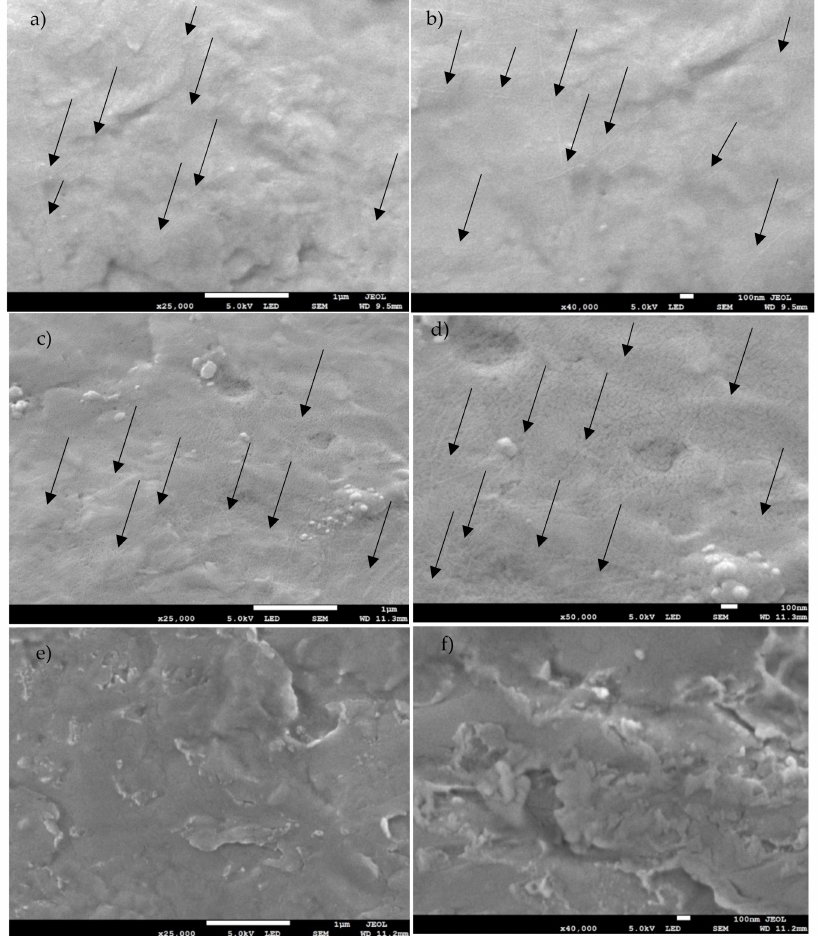
Figure 2. SEM images of Ti6Al4V WPI coated NS with 25,000 × magnification ( a ) and 40,000 × magnification ( b ); WPI coated S at 25,000 × ( c ) and 50,000 × ( d ); Ti6Al4V uncoated at 25,000 × ( e ) and 40,000 × ( f ). Black arrows indicate WPI fibrils. Scale bar: 1 µ m for the 25,000 × images and 0.1 µ m for the more